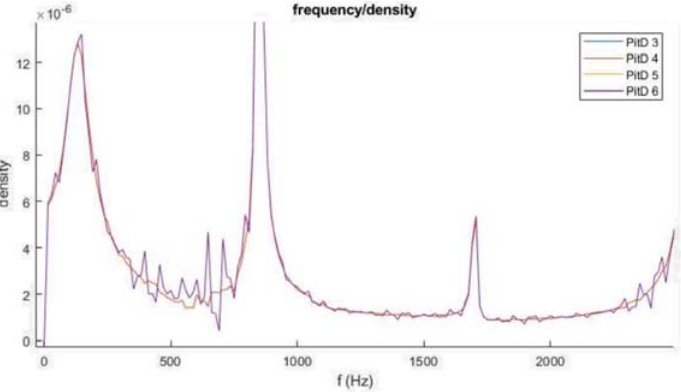
Figure 12. Spectra for damage level D and different positions on the flank. Positions 3 (having coordinates S = 36 and T = 0.5) and 4 (S = 36, T = − 0.5) had the same radial coordinate (S = 36) but different axial coordinates (they lay on opposite sides of the flank). The two spectra were very similar and overlapped, as shown in Figure 12. The same could be observed for the spectra of positions 5 (S = 12, T = 0.5) and 6 (S = 12, T = − 0.5). Therefore, it can be concluded that the data were not significantly affected by the axial position. On the contrary, positions 4 (S = 36, T = − 0.5) and 6 (S = 12, T = − 0.5) differed in the radial coordinate only. The impact of the radial position was visible in the spectra (Figure 12). The same effect could be observed between position 3 (S = 36, T = 0.5) and 5 (S = 12, T = 0.5). Moreover, the smaller pit with code A did not produce meaningful differential spec- tra. In other words, the impact of such small pits on the vibration could not be captured by the numerical model. 3. Basics for Implementation of the Machine-Learning Algorithm A machine-learning (ML) approach based on artificial neural networks (ANNs) was used in this study for damage identification, and to solve the inverse problem of correlat- ing some input features extracted from the observed signals with some damage parame- ters, including (i) a binary variable for damage detection, (ii) damage coordinates for lo- calization, and (iii) damage extent for its assessment. In particular, the ANN used here was the Multilayer perceptron (MLP), consisting of a collection of connected nodes; namely, the input layer nodes, the hidden layer nodes, and the output nodes. In this work, the input nodes collected the input vector (cid:2206), including the frequency pattern of the FFT of the vibration signal, one hidden layer is used for computation, and the output vector (cid:2207) included either a binary variable (for damage detection) or continuous variables for dam- age localization and quantification. The general structure for the MLP is schematized in Figure 13. Each node i was con- nected to each node j in the preceding and the following layers through a connection of weights. Signals passed through each node as follows: in layer k (hidden layer), a weighted sum was performed at each node i of all the signals from the preceding layer, giving the excitation of the node; this was then passed through a nonlinear activation function f to emerge as the output node to the next layer; the activation function f in this case was restricted to (cid:1858)((cid:1876)) = (cid:1872)(cid:1853)(cid:1866)ℎ((cid:1876)) . One node of the network, the bias node b , was spe- cial in that it was connected to all other nodes in the hidden and output layers; the output of the bias node was held fixed throughout to allow constant offsets in the excitations of each node. The response of node i is reported in Equation (3):